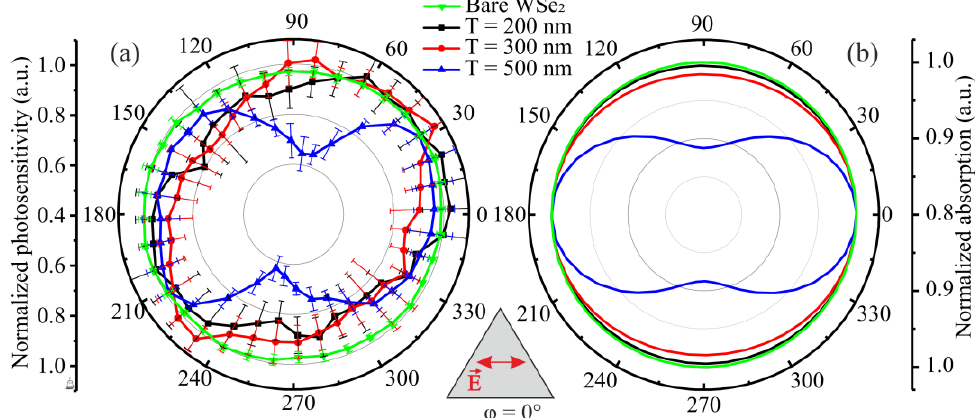
Figure 4. ( a ) Experimentally obtained values of photosensitivity at different polarization angles of incident radiation for photodetectors with plasmonic nanoprisms and ( b ) theoretically calculated absorption in WSe 2 monolayer with plasmonic structures on its surface at incident radiation with wavelength λ = 635 nm. The inset below schematically shows the polarization direction at angle φ = 0°.